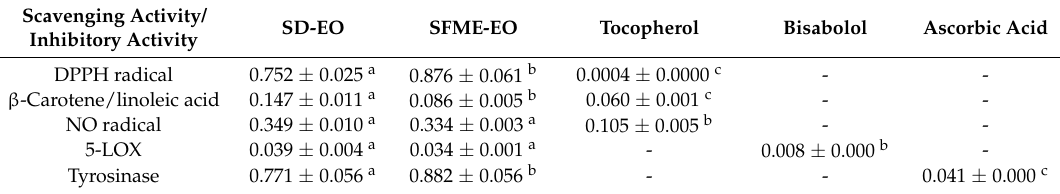
Table 5. Scavenging concentration (SC 50 ) (%, v / v ) and inhibitory concentration (IC 50 ) (%, v / v ) for